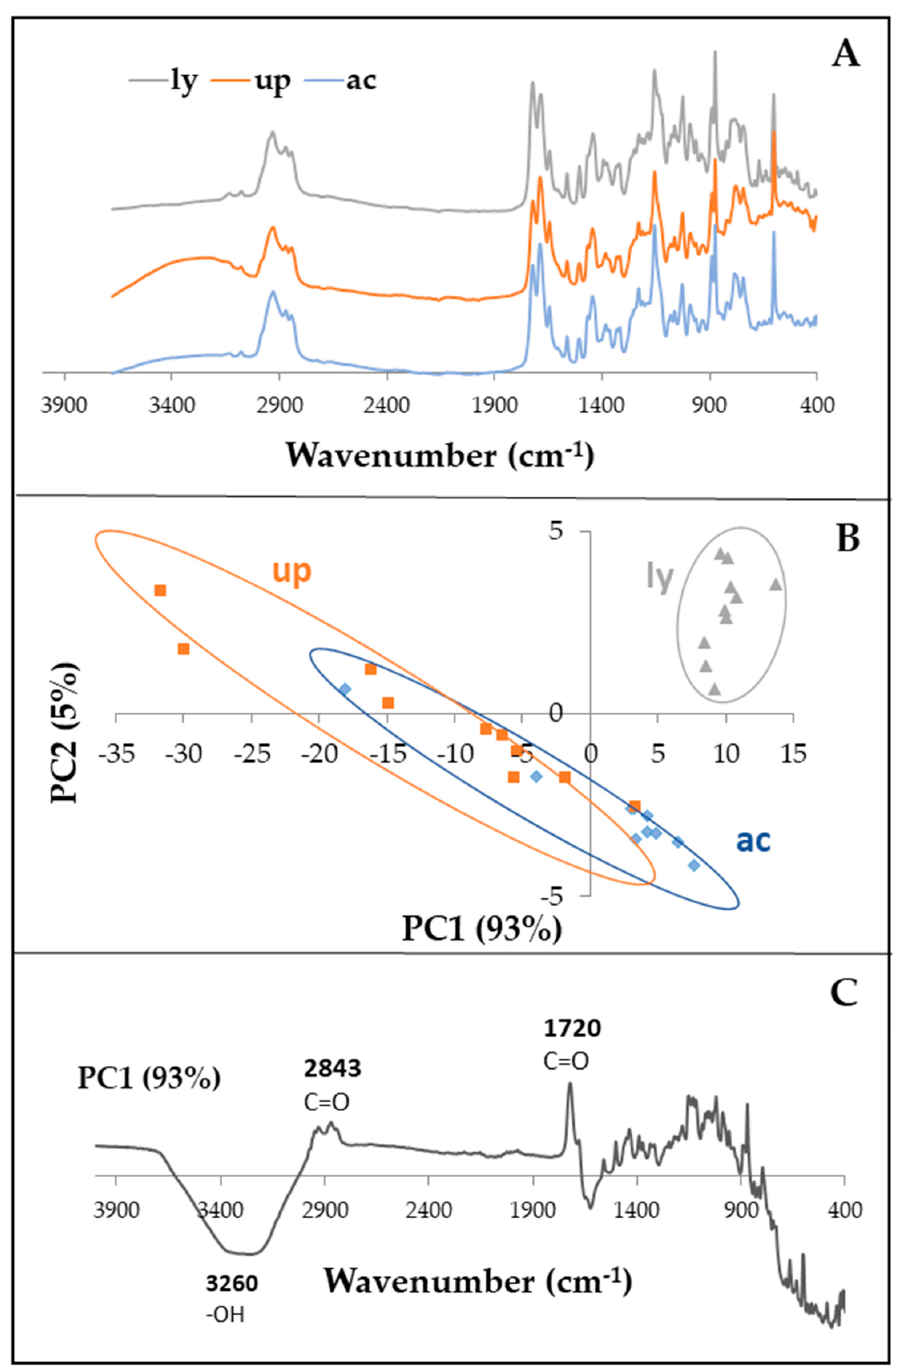
Figure 1. Effects of treatment on resin collected in summer from Sciadopitys verticillata : ( A ) Fourier transform infrared (FTIR) spectra of lyophilized (ly; grey), unprocessed (up; orange), and autoclaved (ac; blue) resin. ( B ) Scores plot of the first two principal components obtained by principal component analysis (PCA) of the FTIR spectra of lyophilized (grey triangles), unprocessed (orange squares), autoclaved (blue circles), and Sciadopitys verticillata (Sv) resin. ( C ) Loadings plot of PC1.